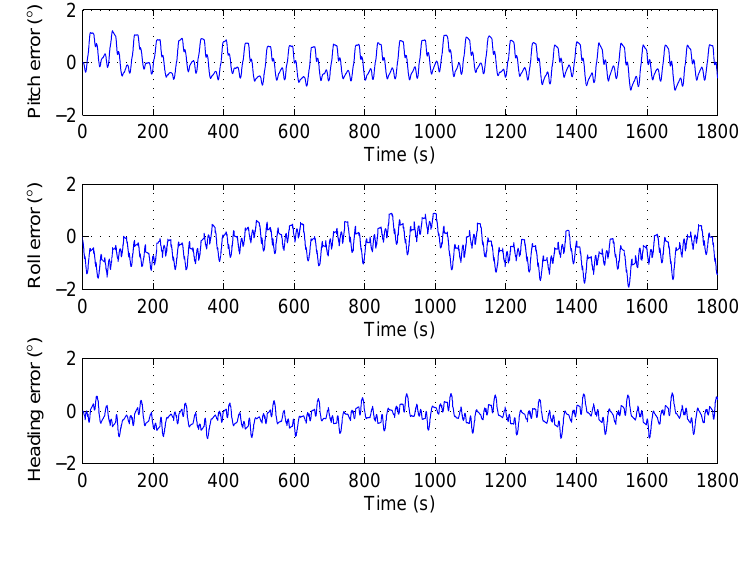
Figure 11. Attitude and heading errors of experiment 1 after installation error compensation.